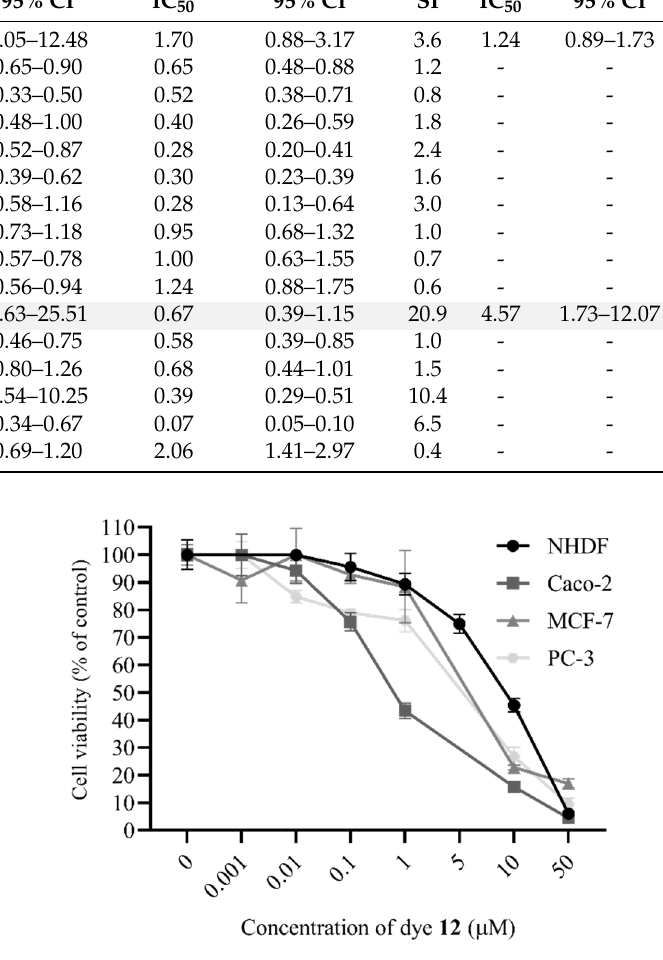
Figure 2. Concentration-dependent in vitro effects of the cyanine dye 12 on the cell viability of human adenocarcinoma cell lines of the prostate (PC-3), breast (MCF-7), and colorectal (Caco-2) cancer cell lines and the non-tumourous cell line of normal human dermal fibroblasts (NHDF) after 72 h of incubation at various concentrations (0, 0.001, 0.01, 0.1, 1, 5, 10, and 50 µM). The results are expressed as the average value ± standard deviation of at least two independent assays performed in quadruplicate.